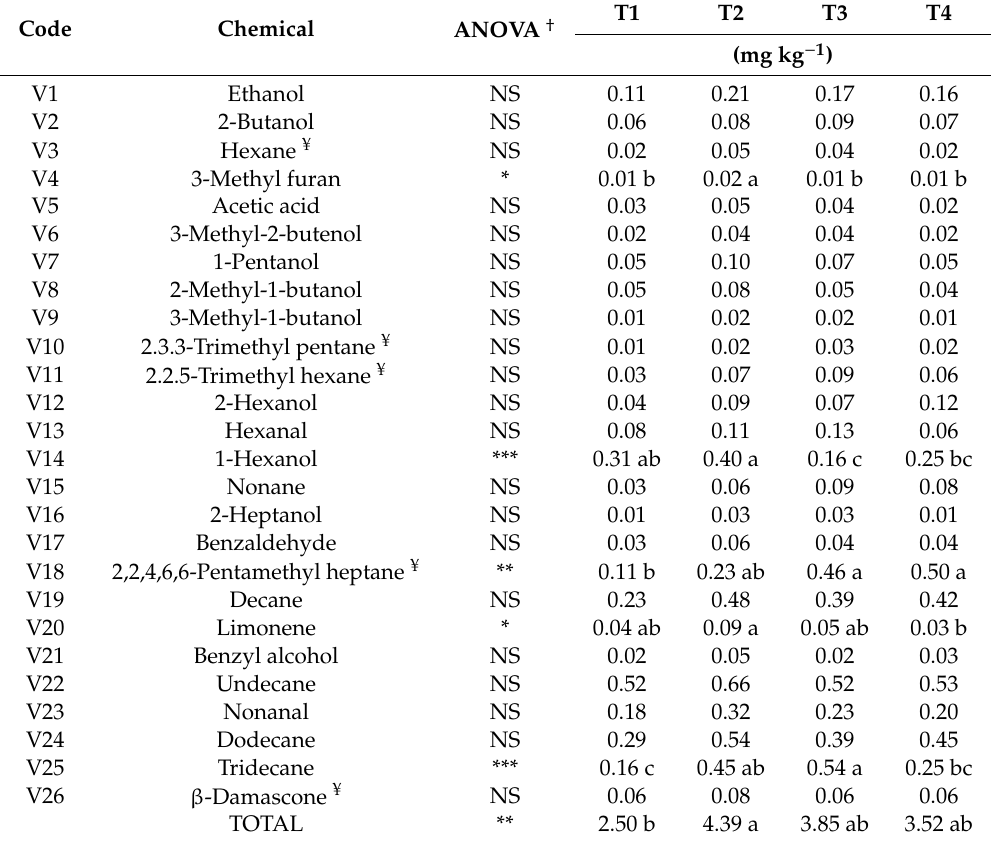
Volatile compounds (mg kg − 1 ) found in raw almonds as a ff ected by water